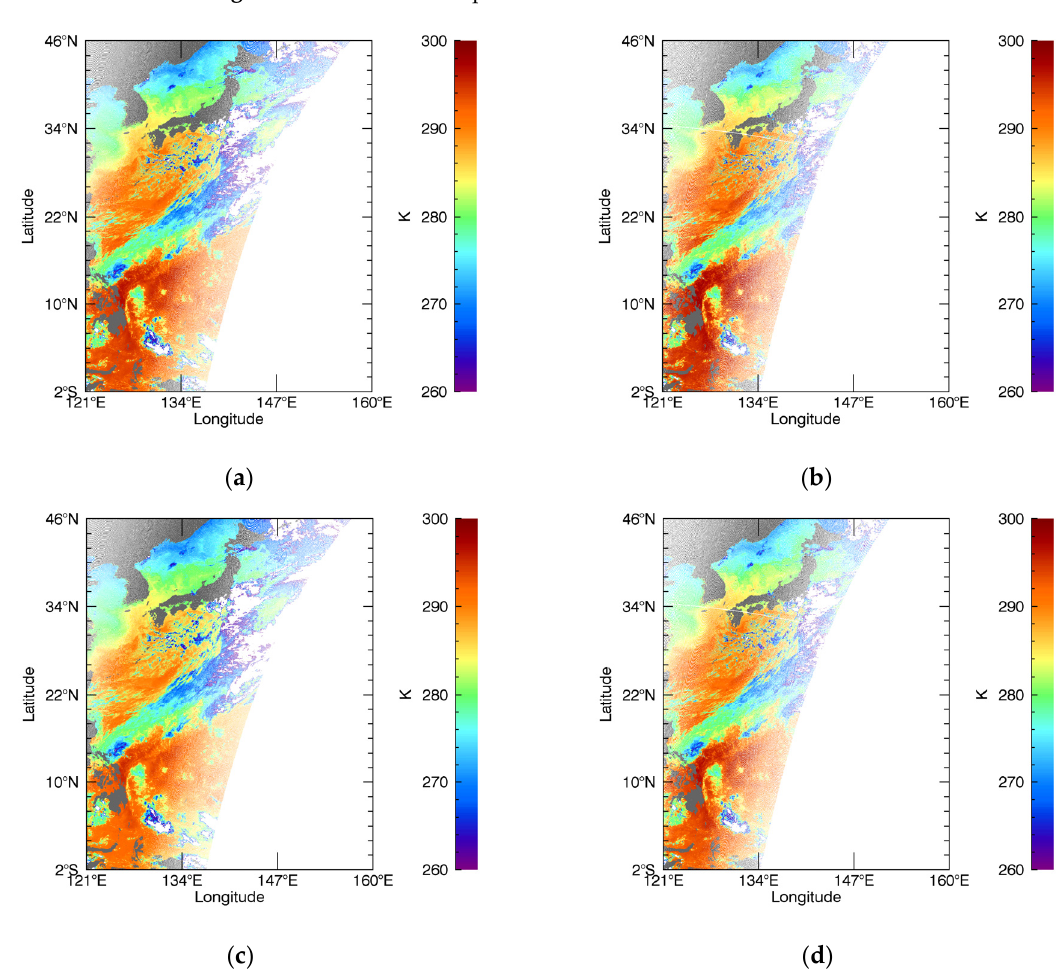
Figure 2. VIRR_BT and MODIS_BT after projection in the daytime of 28 March 2016: ( a ) VIRR 11 μ m channel; ( b ) MODIS 11 μ m channel; ( c ) VIRR 12 μ m channel; ( d ) MODIS 12 μ m channel.